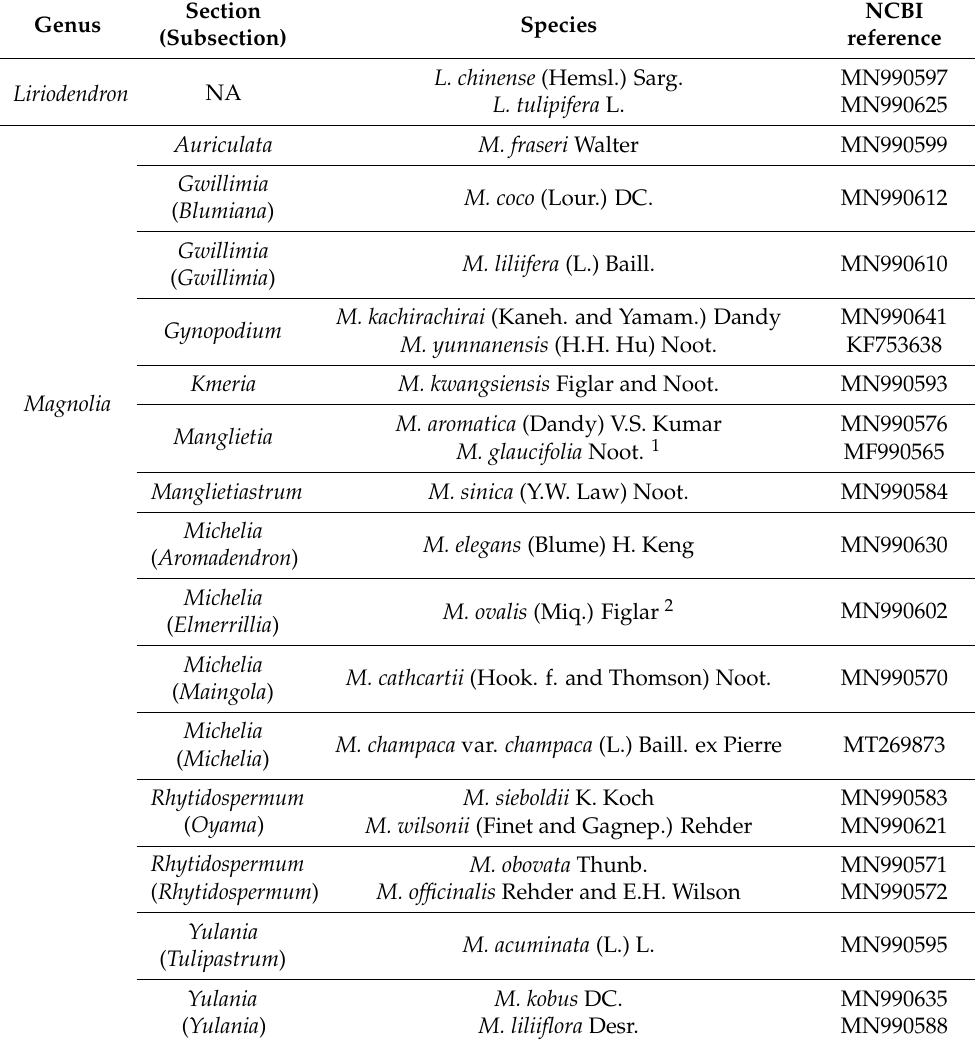
Table 4. Magnoliaceae plastomes downloaded from [39]; the classification is according to [51,60]. NA = Not applicable. 1 : Synonym of Magnolia conifera var. chingii (Dandy) V.S.Kumar. 2 : Synonym of M. vrieseana (Miq.) Baill. ex